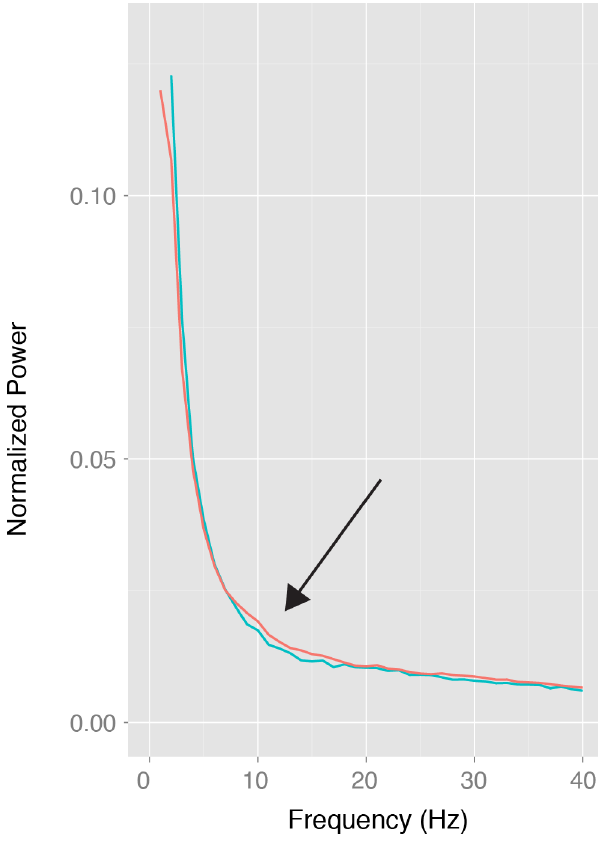
Figure 2. EEG power redistributes with age. Mean normalized power across subjects <=20 years (orange) or >20 years (cyan) is plotted relative to frequency. Frequencies in the alpha range are lower in the older subjects (arrow).